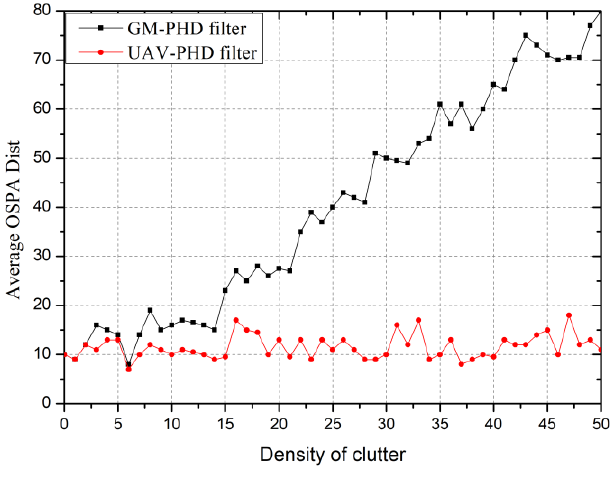
Figure 9. Average OSPA distance at different clutter densities.